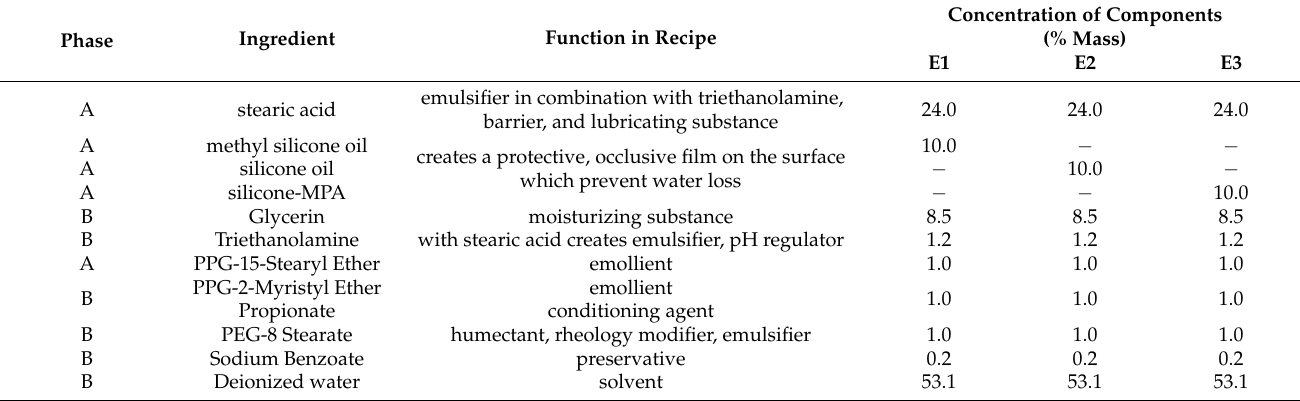
Table 2. Protective cream formulation with silicone oil/thiolated silicone oil intended for use in a wet environment. Oil phase: A, water phase: